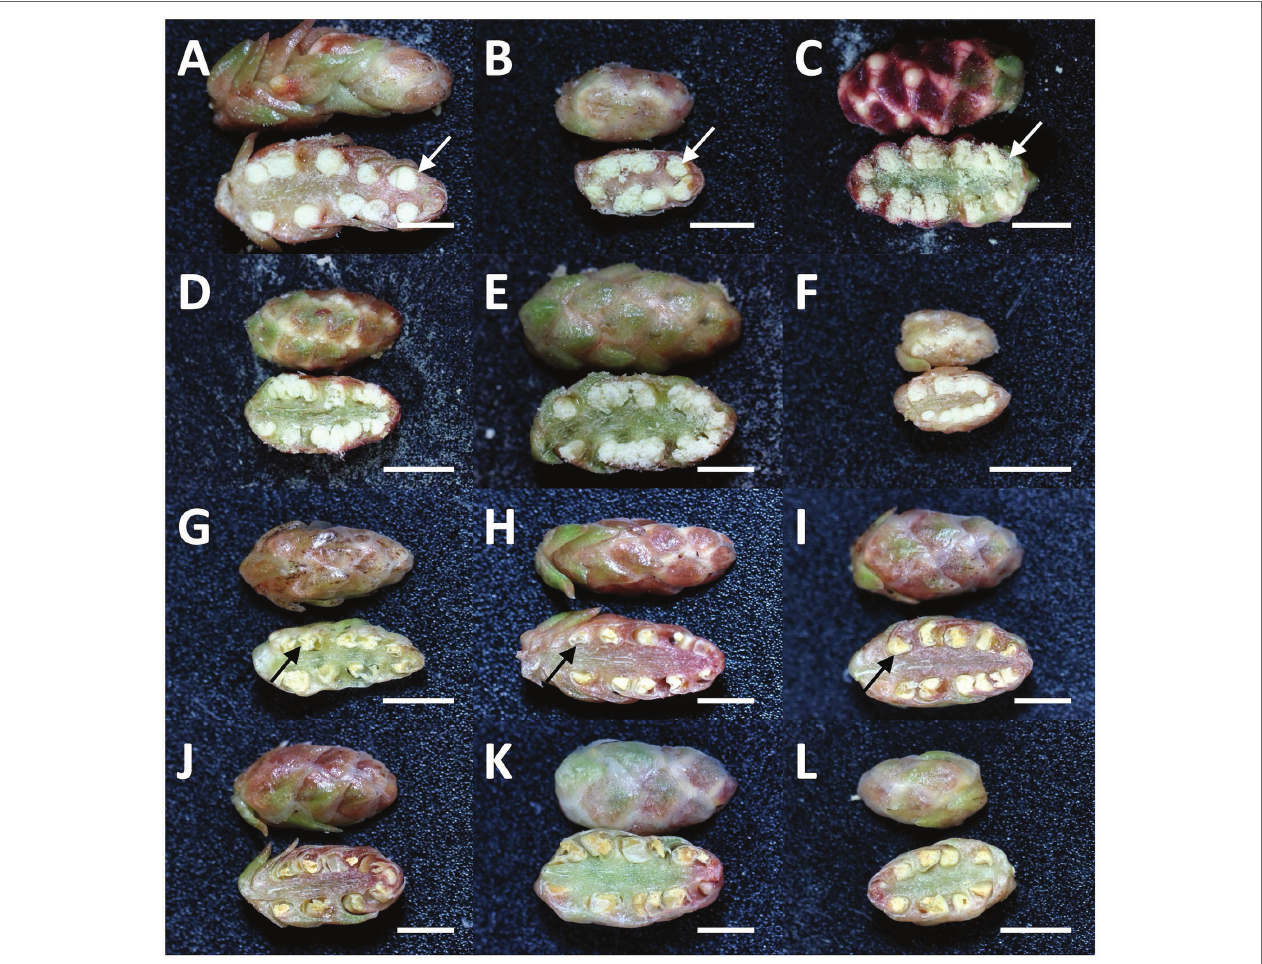
FIGURE 3 | Representative types of dissected male flowers in sugi (Japanese cedar, Cryptomeria japonica ) about 6 months after GA application, (A–F) male flowers of male-fertile lines with normal pollen grains in the anthers (white arrow), (G–L) male flowers of male-sterile (pollen-free) lines without pollen grain (black arrow). Bars : 2 mm.